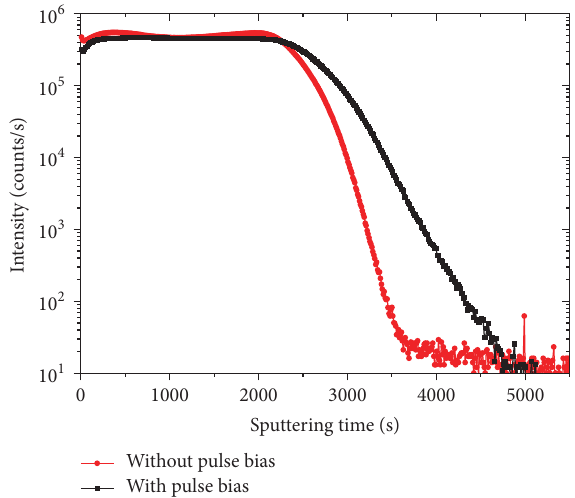
Figure 3: SIMS depth profile of the titanium signal of a sputter deposited Ti film with and without pulse